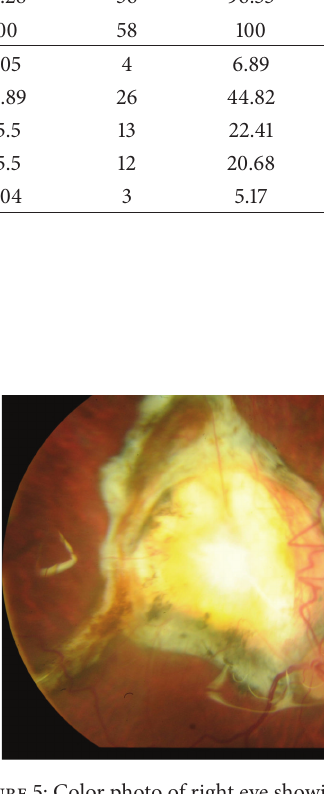
Figure 5: Color photo of right eye showing macular exit.